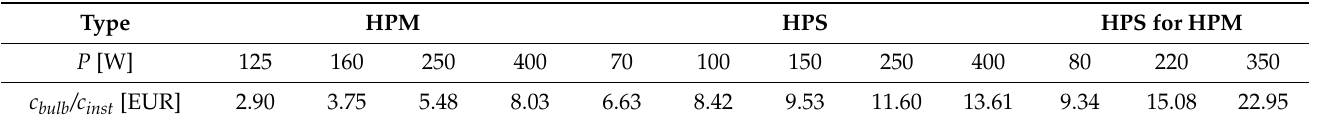
Table 8. The price range of new HPS luminaires at the local market.